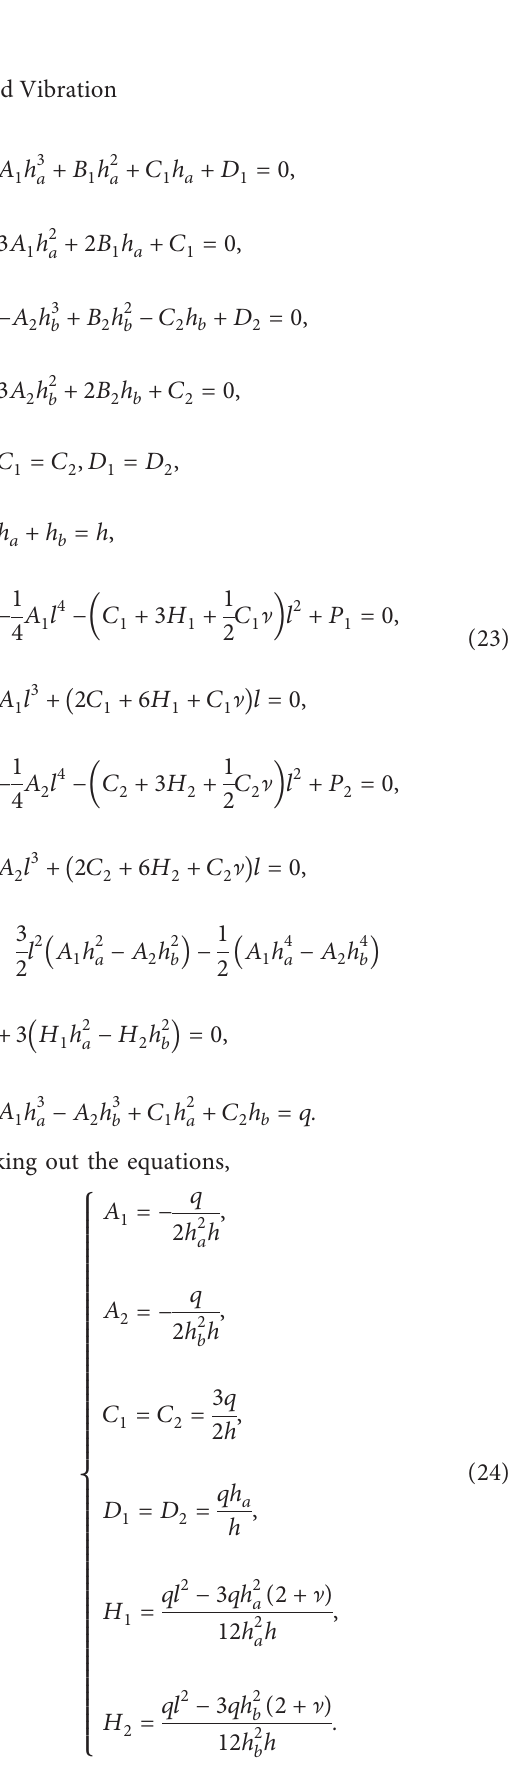
Thus, different components of stress of tensile and pressure zones can be expressed as